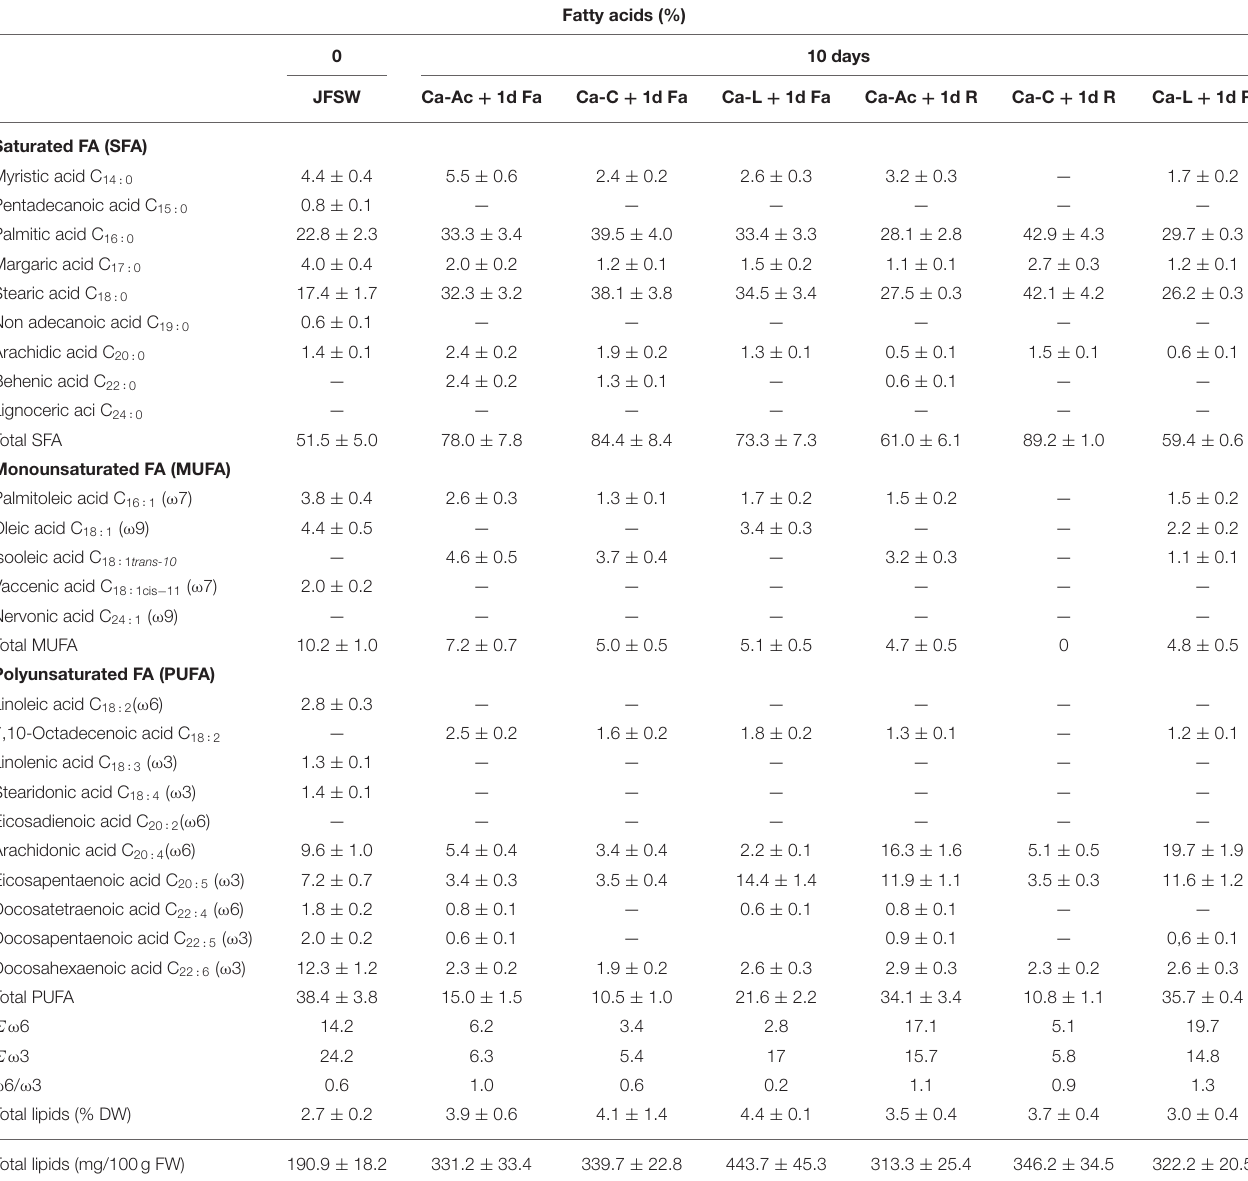
TABLE 5 | Comparison of the fatty acid composition of jellyfish R. pulmo treated for 10 days with different calcium salts and then washed with drinking water and incubated for 1 day at 4 ◦ C with phenolic compounds. Fatty acids